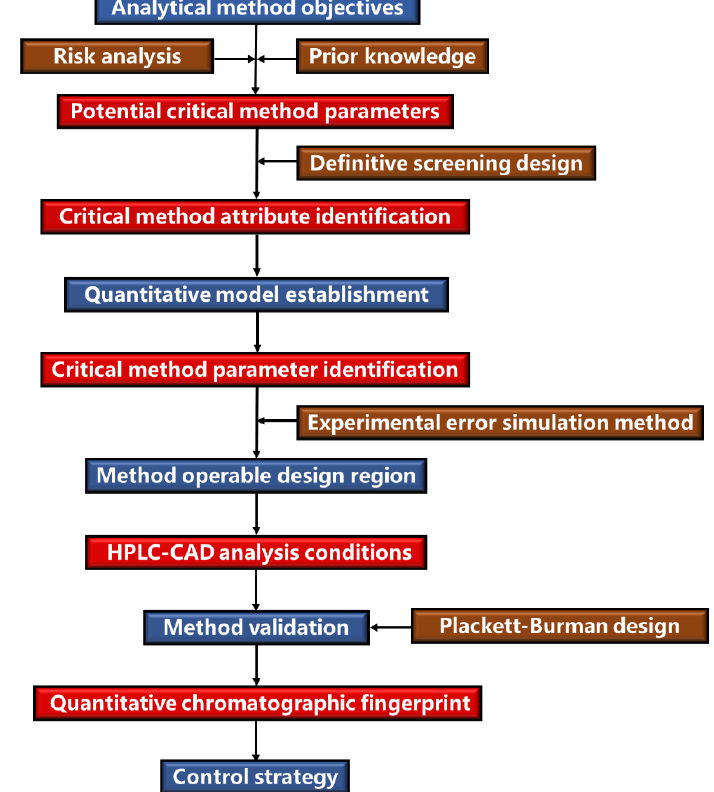
Figure 1. The AQbD process of this work.